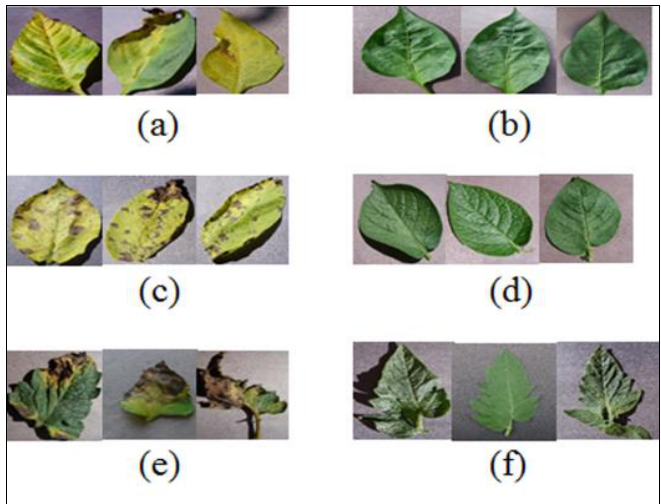
Figure 1: (a) Pepper bell Bacterial spot (b) Pepper bell healthy (c) Potato early blight (d)Potato healthy (e) Tomato Early blight (f) Tomato